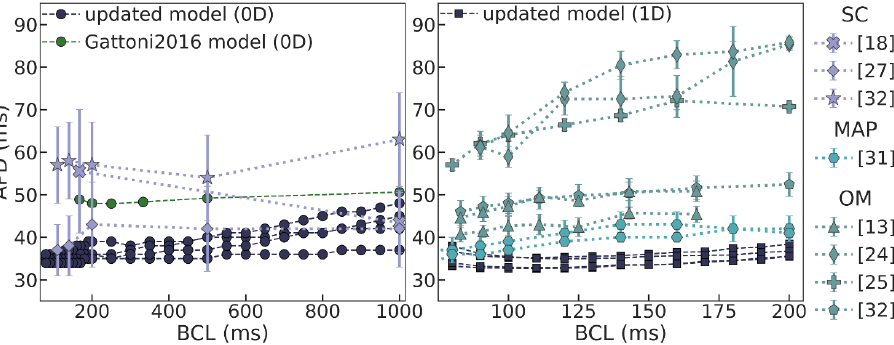
Figure A2. Restitution curves: simulations against experimental data. Left panel, single-cell (SC) data: restitution curves measured in experiments on SC using microelectrode techniques (SC: Gattoni et al. 2016 [18], Hardy et al. 2018 [27], Benoist et al. 2012 [32]) combined with simulation results from the original and updated Gattoni2016 cellular models. Right panel, tissue data: restitution curves measured in myocardial tissue using monophasic action potential (MAP: Benoist et al. 2011 [31]) and optical mapping (OM: Lee et al. 2016. [25], Annoni et al. 2015 [24], Benoist et al. 2012 [32], Walton et al. 2013 [13]) in rat heart combined with simulation results from the updated models of a myocardial tissue strip.